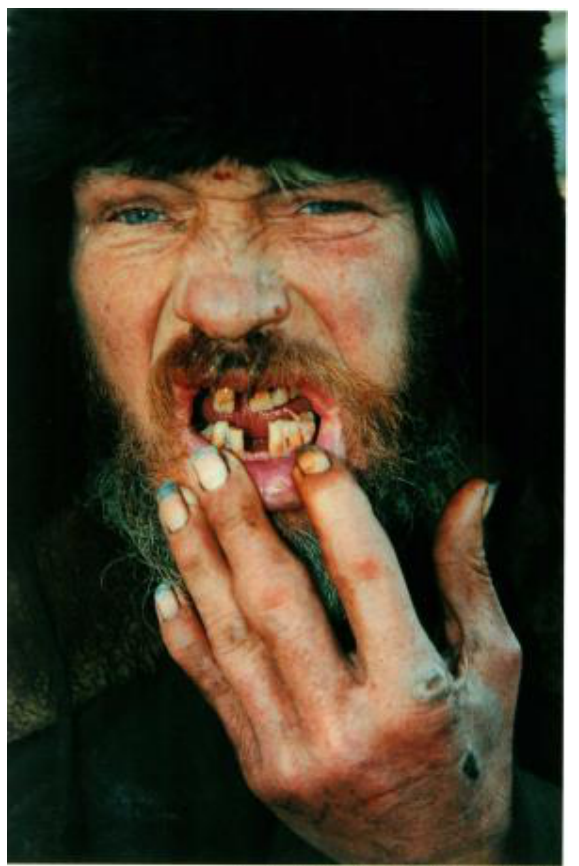
Figure 3 Boris Mikhailov, Untitled , from the series Case History (1997 – 98). Chromogenic color print, dimensions variable. Copyright Boris Mikhailov; courtesy Pace/MacGill Gallery, New